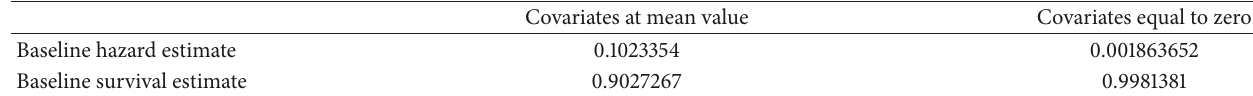
Table 5: Baseline hazard and survival at 10